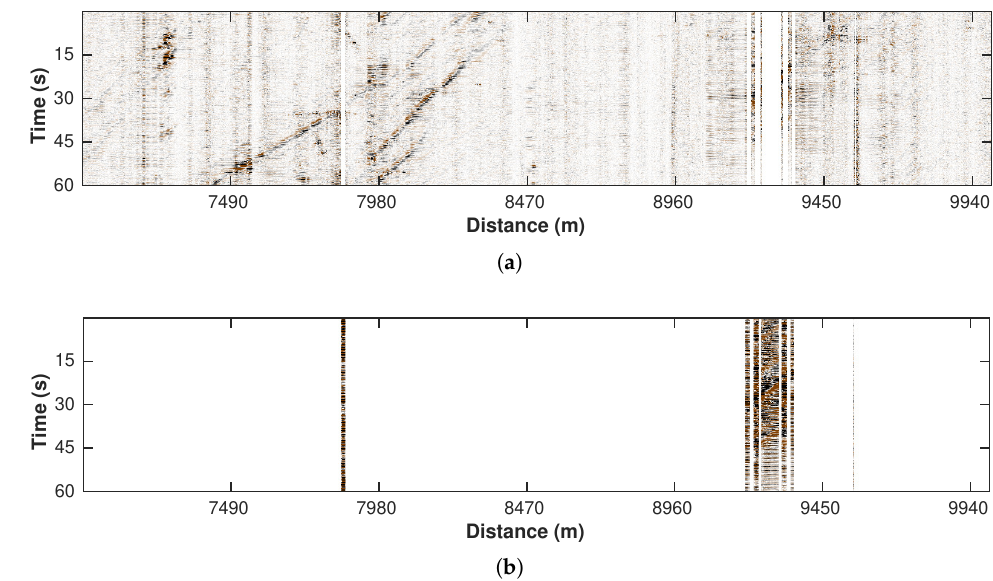
Figure 8. ( a ) Trace editing result. ( b ) Removed